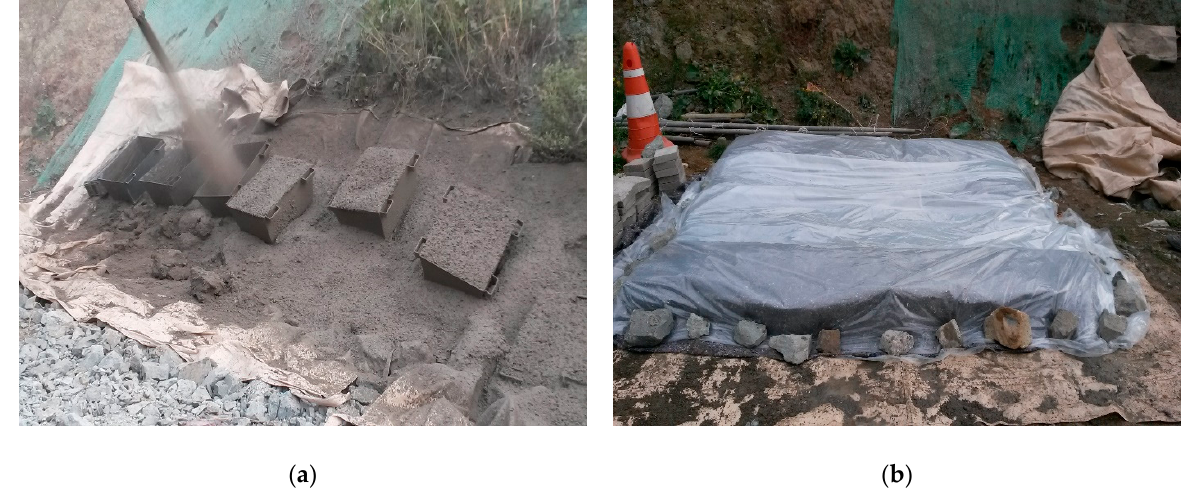
Figure 1. Test sample preparation, ( a ) Shooting at test panels, ( b ) Sample